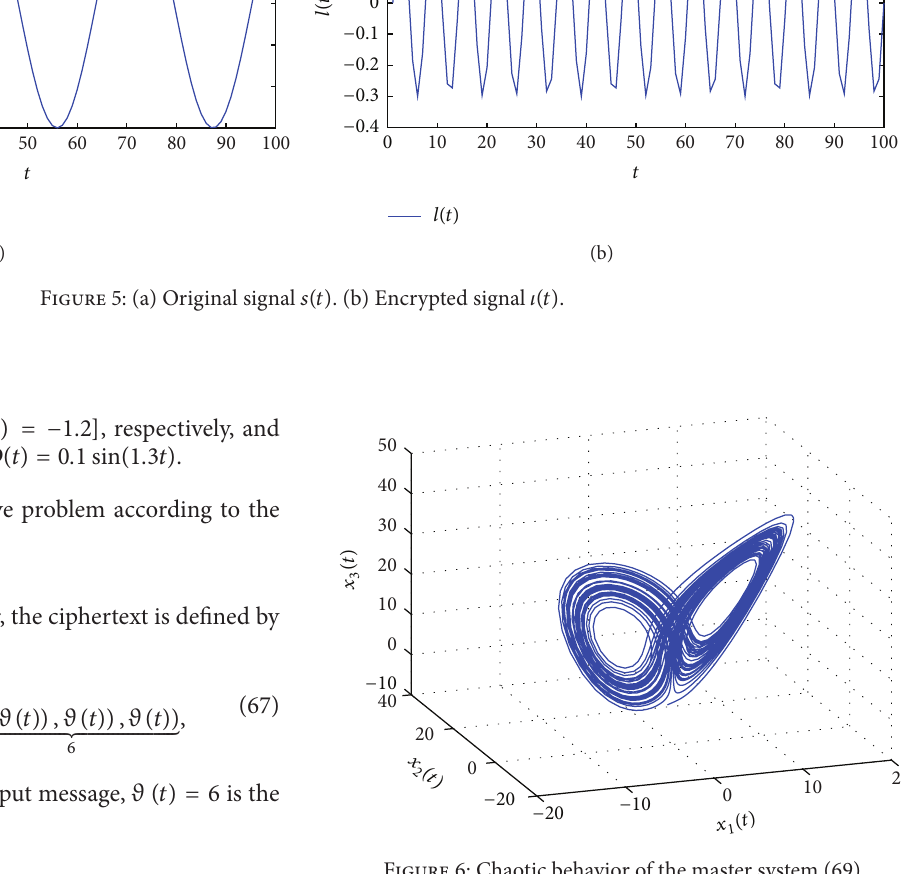
Figure 6: Chaotic behavior of the master system